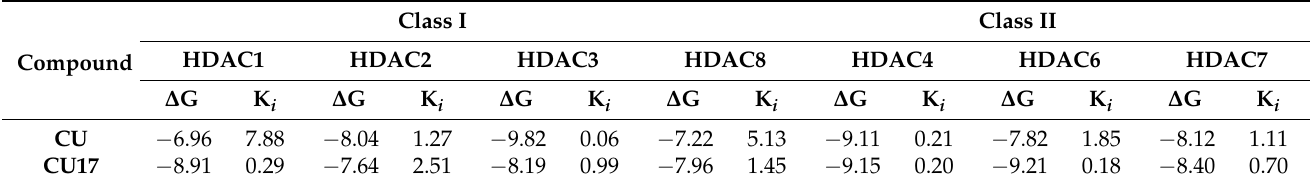
Table 1. In silico histone deacetylase inhibitory activity of CU and CU17.